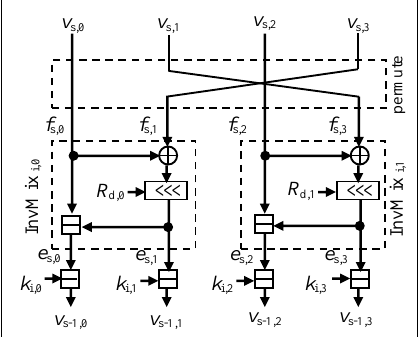
Figure 3. Single round of Threefish256 decryption